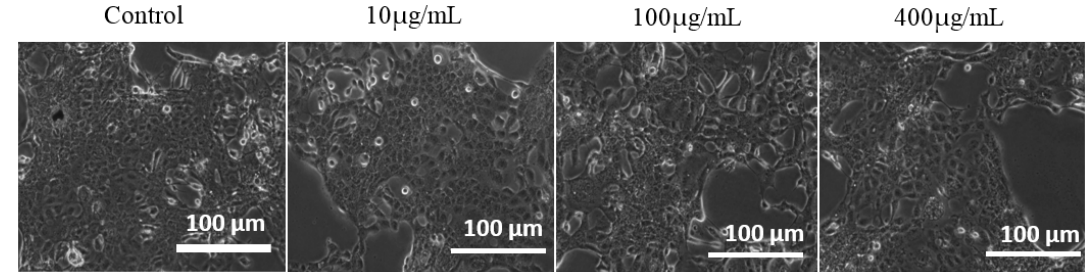
Figure 8. Light microscopy images of A431 cells treated with different dosages of the Fe 3 O 4 /HAp Figure 8. nanocomposite.